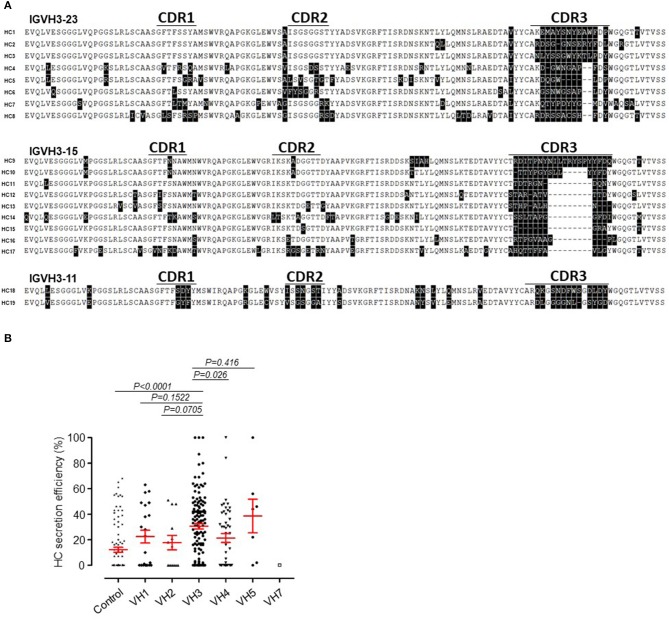
Sequence inconsistency and usage of VH family genes in SLE HCAbs. (A) No obvious sequence similarity among 19 HCAbs encoded by three VH germline genes in CDR3. (B) Comparison of the secretion efficiency of SLE HCAbs encoded by 6 VH germline gene families. The P-value was determined by Mann-Whitney U-test.